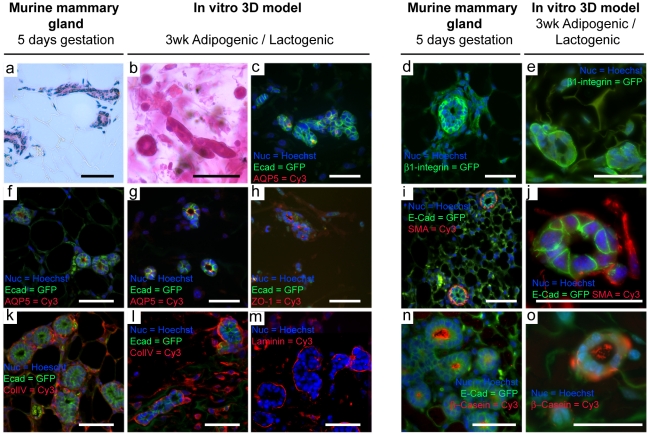
3T3-L1/KIM-2 co-culture in defined collagen/hyaluronic acid scaffolds generate bilayed, functional mammary epithelial organoids.H&E (a,b) and immunohistochemical (c-o) comparison of epithelial organoid formations in vitro with murine gland (scale bars  = 50 µm, except j,o  = 30 µm). Examples of branched ducts in vivo (a) and in vitro (b,c). Like the native gland at 5days gestation, epithelial organoids display polarity with AQP5 (g) and ZO-1 (h) towards a luminal cavity and integrin β-1 (e) and basement membrane constituents colIV (l) and laminin (m) at the basal surface. SMA(+) myoepithelial cells surround luminal epithelial cells (j), characteristic of the epithelial bilayer in vivo (i). With lactogenic stiumuli, organoid acinar-like structures express β-casein in a luminal cavity (o) as in the native gland (n).